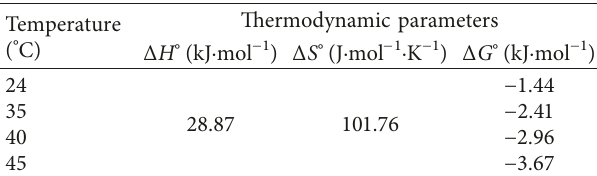
Figure 11: Representation of ln( K T . e ) as a function of 1/ Table 4: Thermodynamic parameters of phosphorus adsorption on the Oued Boufekrane sediments as a function of